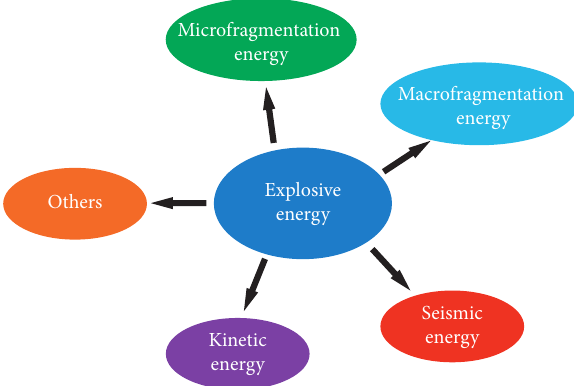
Figure 1: Energy components of explosive in